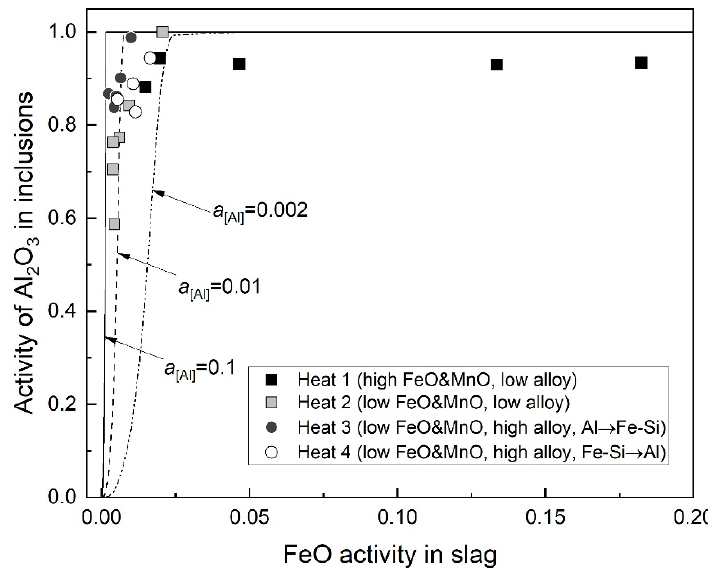
Figure 17. Relation between the FeO activity in the top slag and the Al 2 O 3 activity in the inclu- sions.